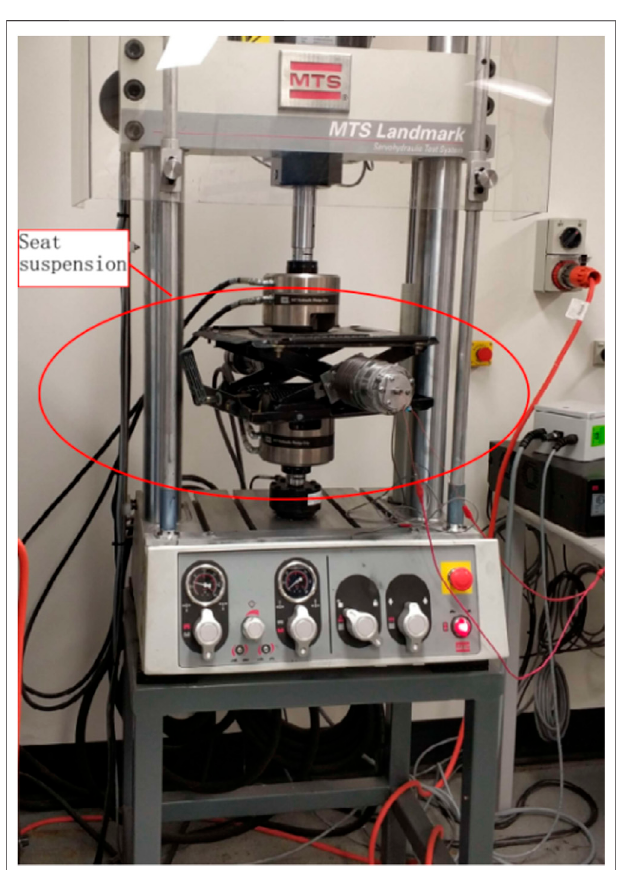
FIGURE 3 | Experimental setup of the MTS testing.